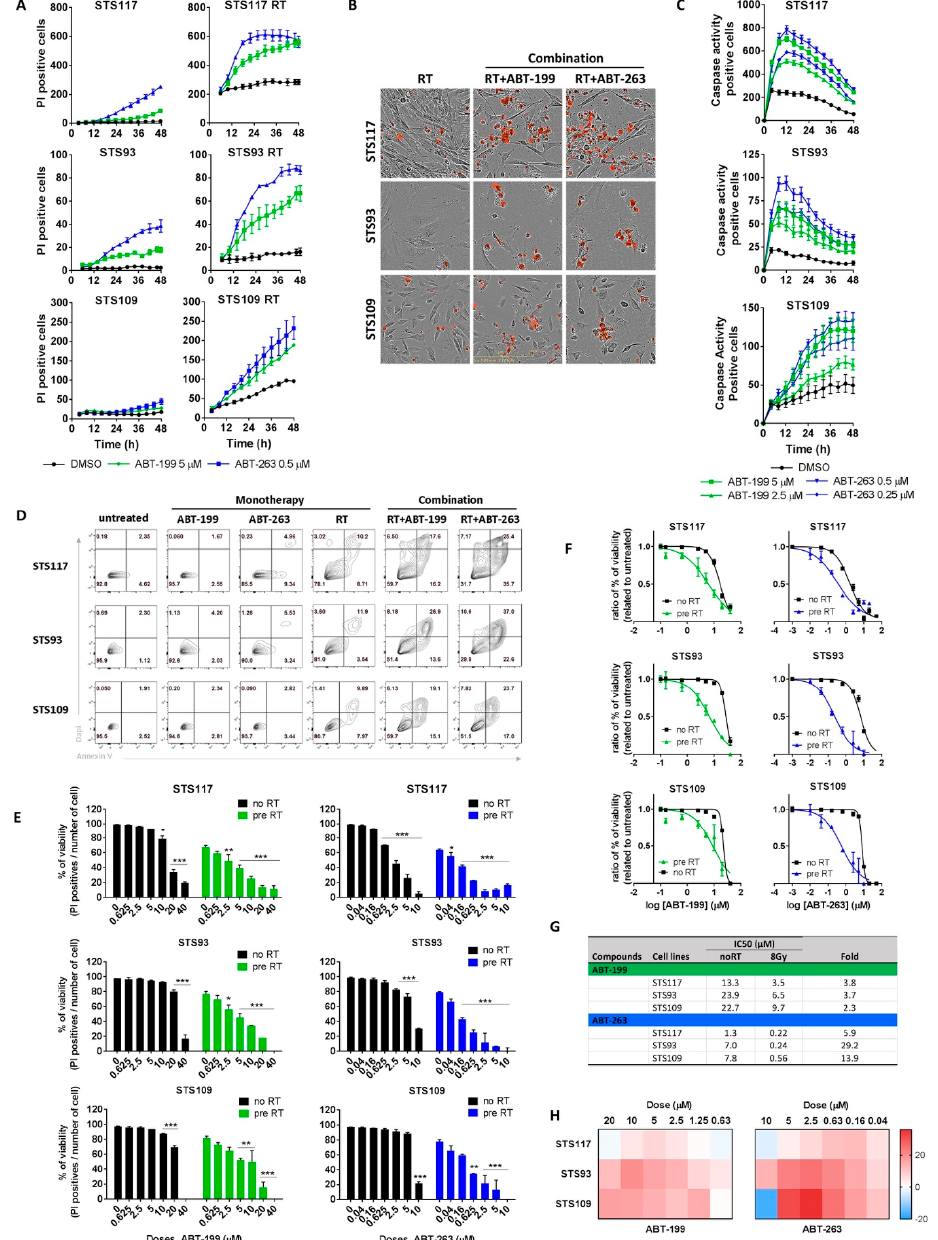
Figure 4. ABT-263 or ABT-199 induces rapid and specific cell death in irradiated sarcoma cells. ( A ) Real-time cell death curve of propidium iodide (PI) incorporation in untreated (left) or pre-irradiated (RT; 8 Gy, 5 days before) (right) sarcoma cell lines treated with ABT-263 (0.5 μ M) or ABT-199 (5 μ M). ( B ) Representative images of PI staining in irradiated cells treated with vehicle, ABT-263 or ABT-199. ( C ) Caspase 3-7 activity in pre-irradiated cells (8 Gy) treated with ABT-263 (0.25 and 0.5 μ M) or ABT-199 (2.5 and 5 μ M). ( D ) Flow cytometry analysis of apoptosis in untreated cells, cells treated with ABT-199 (10 µ M) or ABT-263 (1 µ M) or RT alone (8 Gy) (monotherapy), and pre-irradiated cells treated with either senolytic in combination. ( E ) Cytotoxicity evaluated by percentage of PI positive cells over total number of cells (Cell viability (%)) in control or pre-irradiated cells (8 Gy) 48 h after treatment with increasing doses of ABT-199 or ABT-263. ( F ) Doses response curves for ATB-199 and ABT-263 treatment of RT (8 Gy) or untreated cells for in each cell lines evaluated from % of viability relative to DMSO exposed cells. ( G ) IC50 values for both compounds. ( H ) Heat map of Excess over bliss for combination treatments of radiation and different concentrations of ABT-263 and ABT-199. Data in ( E ) were analyzed using ANOVA for multiple comparison with the vehicle treated control. * p < 0.05, ** p < 0.01, *** p < 0.001. Data are representative of three experiments and the Bliss score data are the mean of three independent experiments. Error bars indicate ± the standard